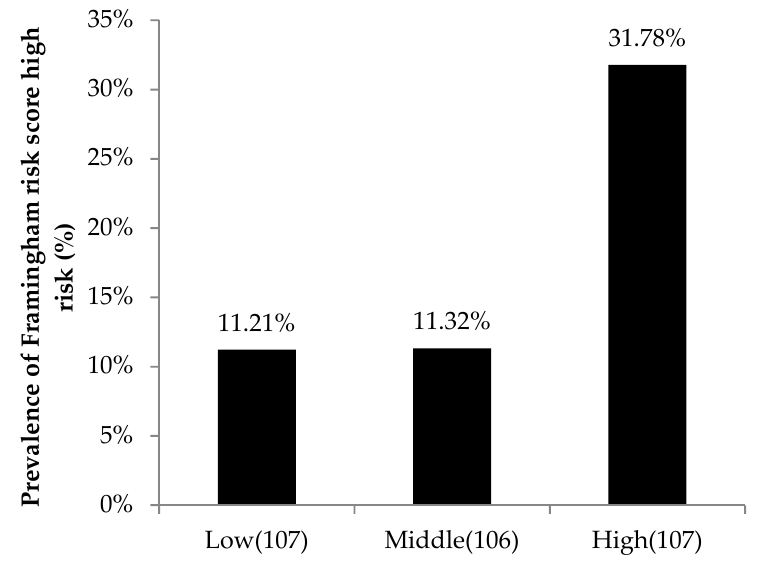
Figure 1. Prevalence of high FRS (FRS ≥ 20%) according to the tertiles of the HOMA-IR index levels. The prevalence of high FRS was higher among the high HOMA-IR tertile than among the two lower tertiles.